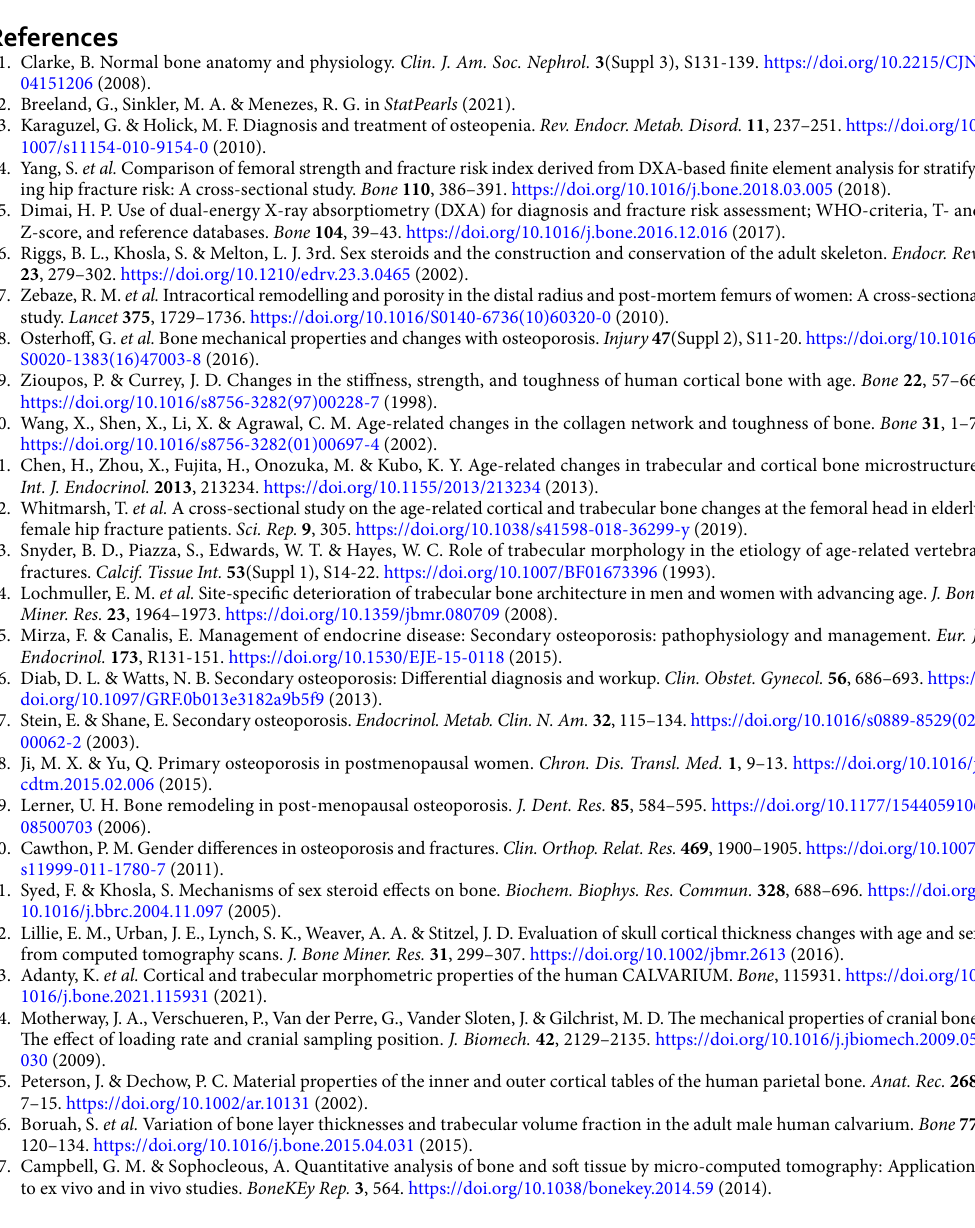
Figure 6. μCT imaging analysis for the mandible. ( A ) 3D reconstruction of the mandible (top) and overview of VOI selection for trabecular bone at M1 bifurcation (1) and the mandibular condyle (2). Scale bar 1 mm and 0.5 mm, respectively. ( B ) Original coronal cross-sectional images of mandibular trabecular bone at M1 bifurcation of male and female mice at 6, 12, 18, and 22 months of age. Scale bar, 1 mm. ( C ) Mandibular trabecular bone mineral density as Tb.BMD in mg HA/cm 3 for male (blue lines) and female (red lines) mice at 6, 12, 18, 22 months of age. Quantification of morphometric parameters of mandibular trabecular bone of males (blue lines) and females (red lines). Trabecular bone volume fraction (BV/TV), trabecular thickness (Tb,Th, µm), trabecular space (Tb.Sp, μm), and trabecular number (Tb.N, 1/mm). ( D ) Original coronal cross-sectional images of mandibular condyle of male and female mice at 6, 12, 18, and 22 months of age. Scale bar, 0.5 mm. ( E ) Original sagittal cross-sectional images of mandibular condyle of male and female mice at 6, 12, 18, and 22 months of age. Scale bar, 0.5 mm. ( F ) Condylar trabecular bone mineral density as Tb.BMD in mg HA/cm 3 for male (blue lines) and female (red lines) mice at 6, 12, 18, 22 months of age. Quantification of morphometric parameters of the mandibular condyle of males (blue lines) and females (red lines). Trabecular separation (Tb. Sp, µm). n = 3 per group. * p < 0.05, ** p < 0.01, *** p < 0.001 for males; # p < 0.05, ## p < 0.01, ### p < 0.001 for females; ns, not